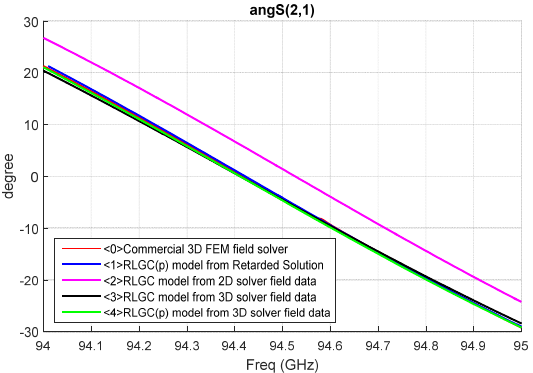
Figure 15: Phase of S21 from 94 GHz to 95 GHz